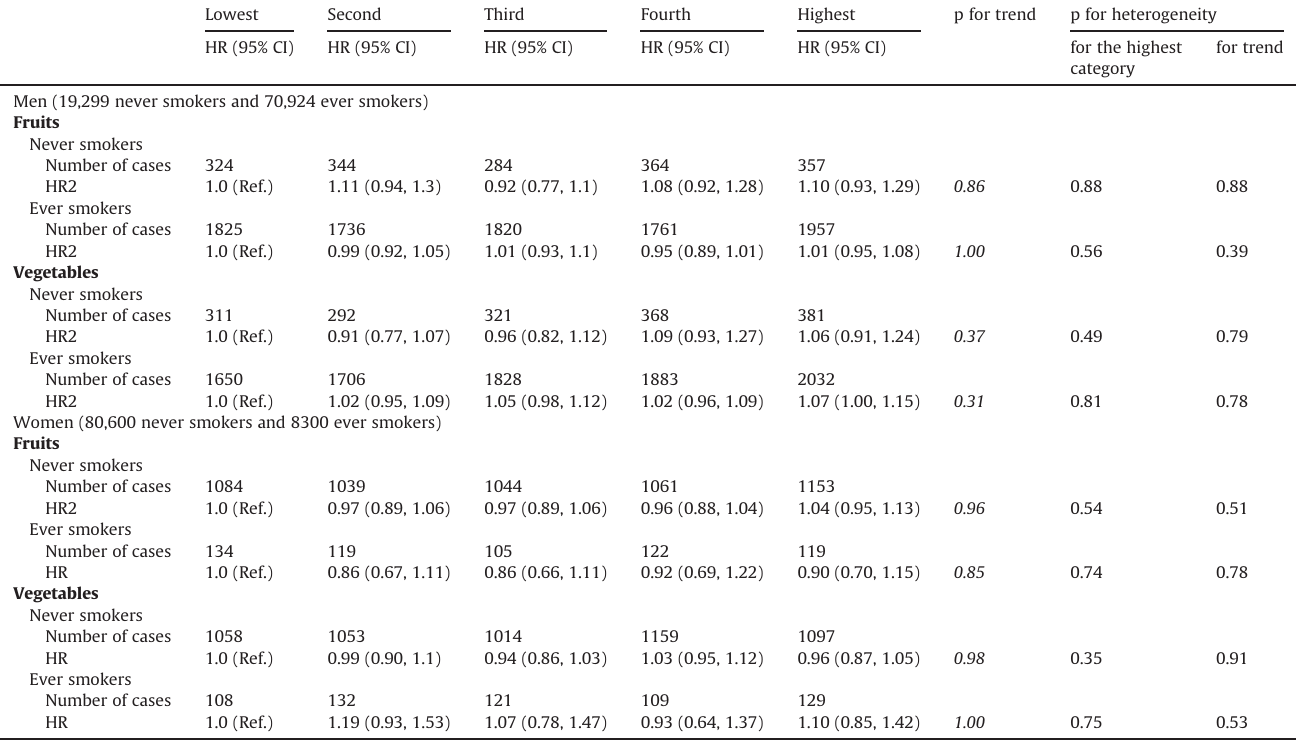
Table 3 Pooled analysis of overall cancer incidence according to quintile of fruit and vegetable consumption, strati fi ed by smoking status, in Japanese men and women. Lowest Second Third Fourth Highest p for trend